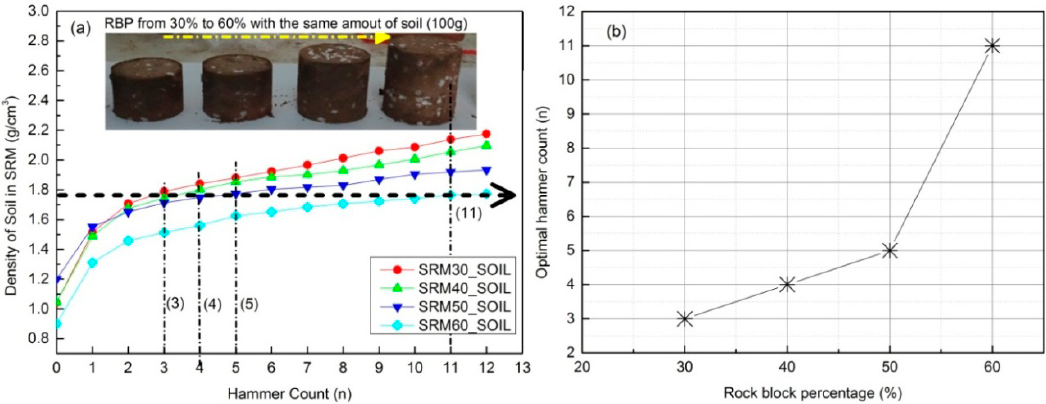
Figure 6. The methods to keep the same soil density in bimsoil samples: ( a ) relationship between the density of soil matrix and hammer count, for samples with RBP of 30–60%, and 100 g soil matrix; and ( b ) determination of the optimal hammer count for bimsoil sample.